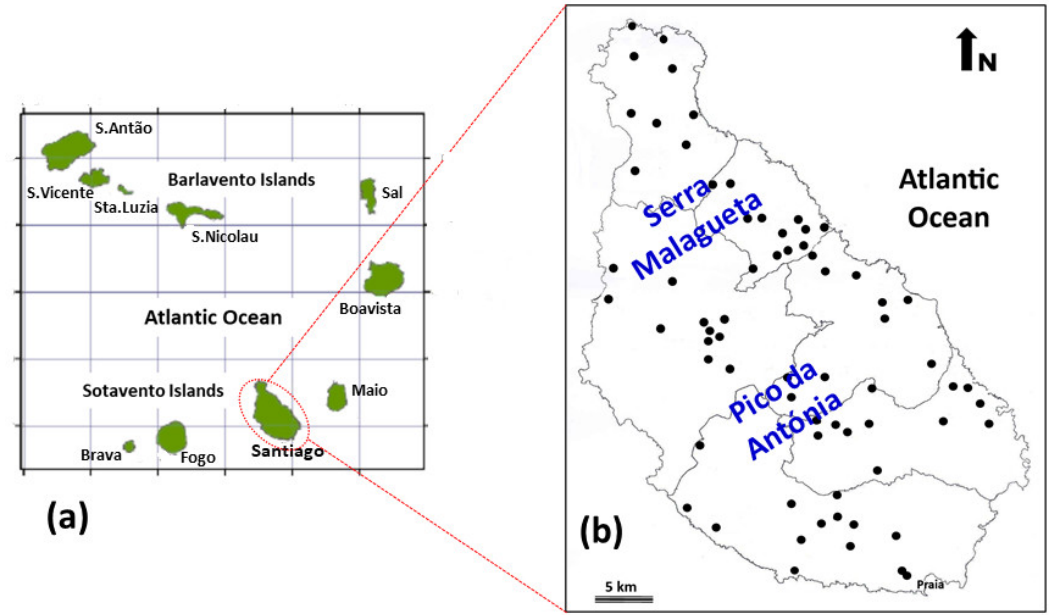
Figure 1. ( a ) Republic of Cape Verde archipelago location the start stands for the (adapted from [38]) ( b ) Location of the sampling points at Santiago Island.